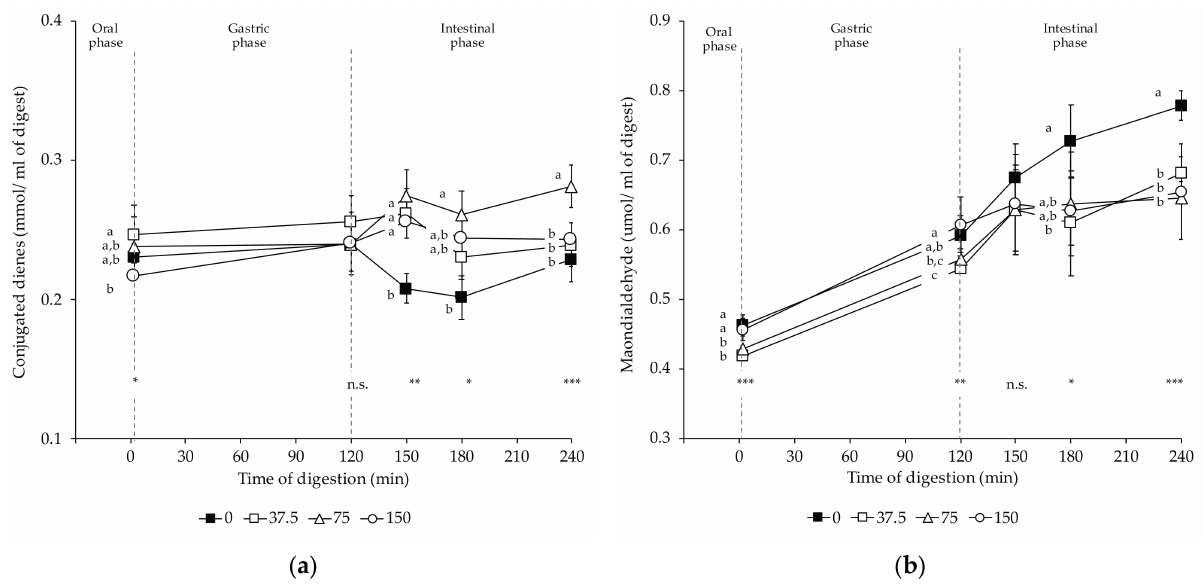
Figure 4. Changes in lipid oxidation products in dry-cured loins formulated with different amounts of NO 2 Na/NO 3 K (0, 37.5, 75, and 150 mg/kg) during in vitro gastrointestinal digestion: ( a ) conjugated dienes; ( b ) malondialdehyde. The time 2 min represents the end of the oral phase, time 120 min, the end of the gastric phase; meanwhile, times 150 and 180 min represent intermediate times of the intestinal phase that ends at time 240 min. *: p < 0.05; **: p < 0.01; ***: p < 0.001. a,b,c: Means for the same time of sampling with different letters are significantly different ( p ≤ 0.05, Tukey’s